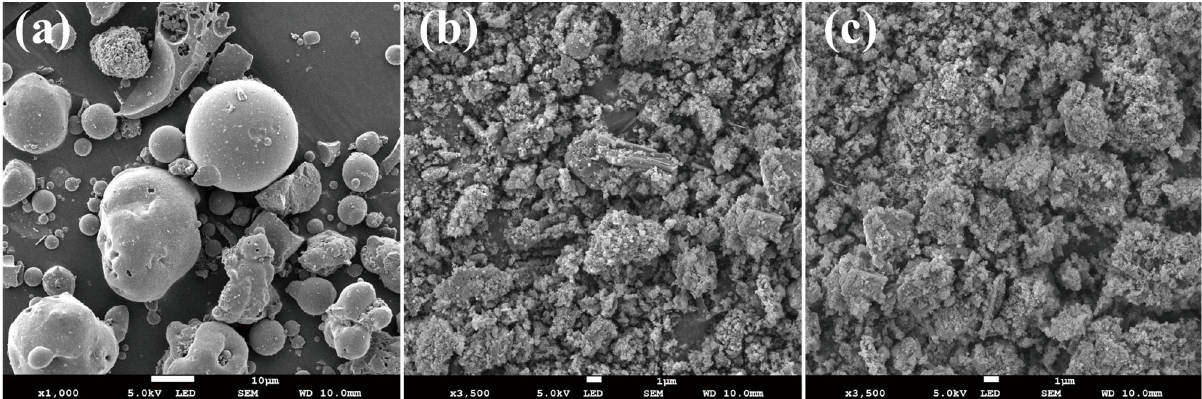
Figure 3. Morphology images of ( a ) CFA; ( b ) NaOH ‐ CFA; and ( c ) NaOH ‐ CFA adsorbing ammonia nitrogen.